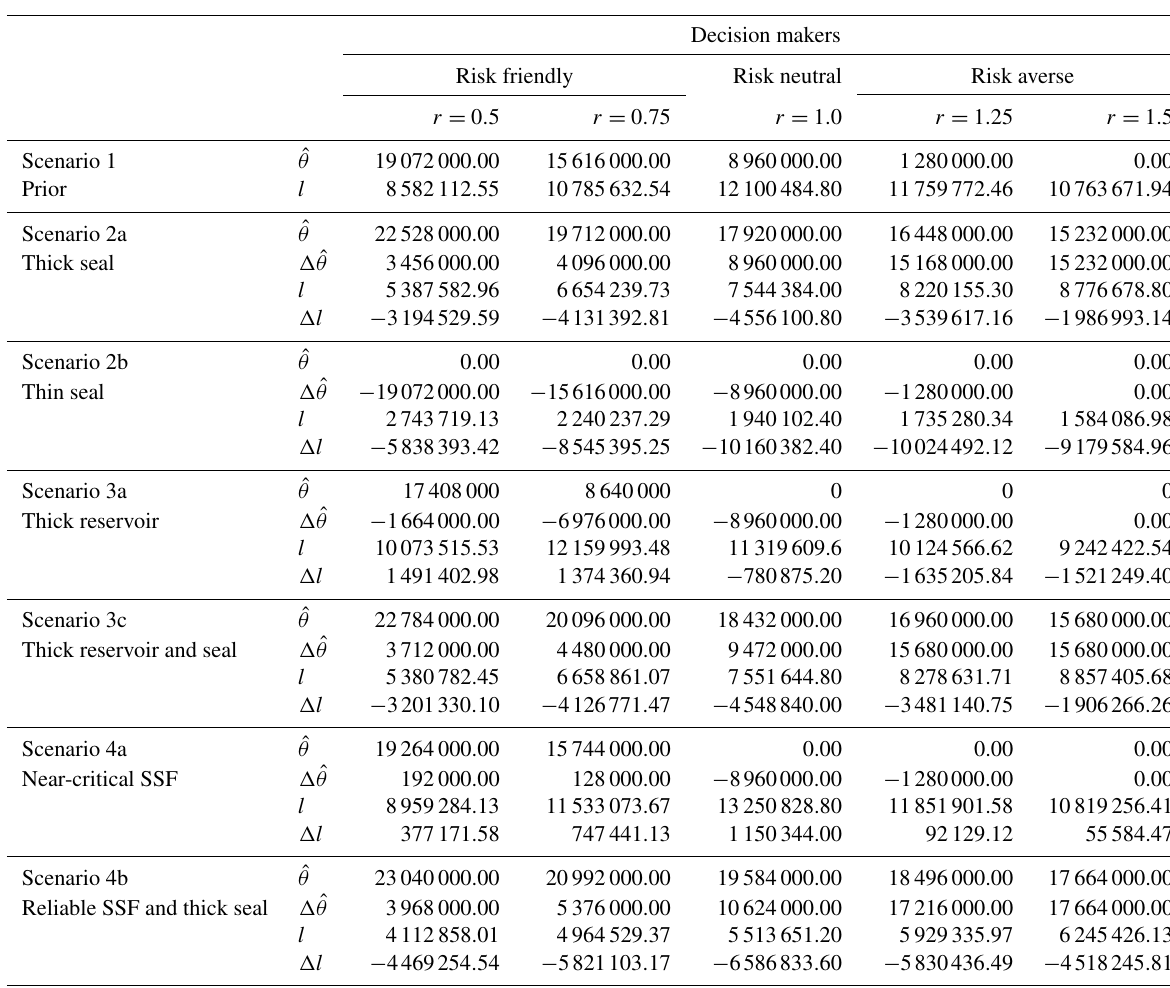
Table B1. Decision results for all considered scenarios and each actor. Respective optimal estimates (decisions) are represented by ˆ θ , while (cid:49) ˆ θ indicates posterior changes relative to the prior (Scenario 1) result. Expected losses are given by l , and changes relative to the prior by (cid:49)l .